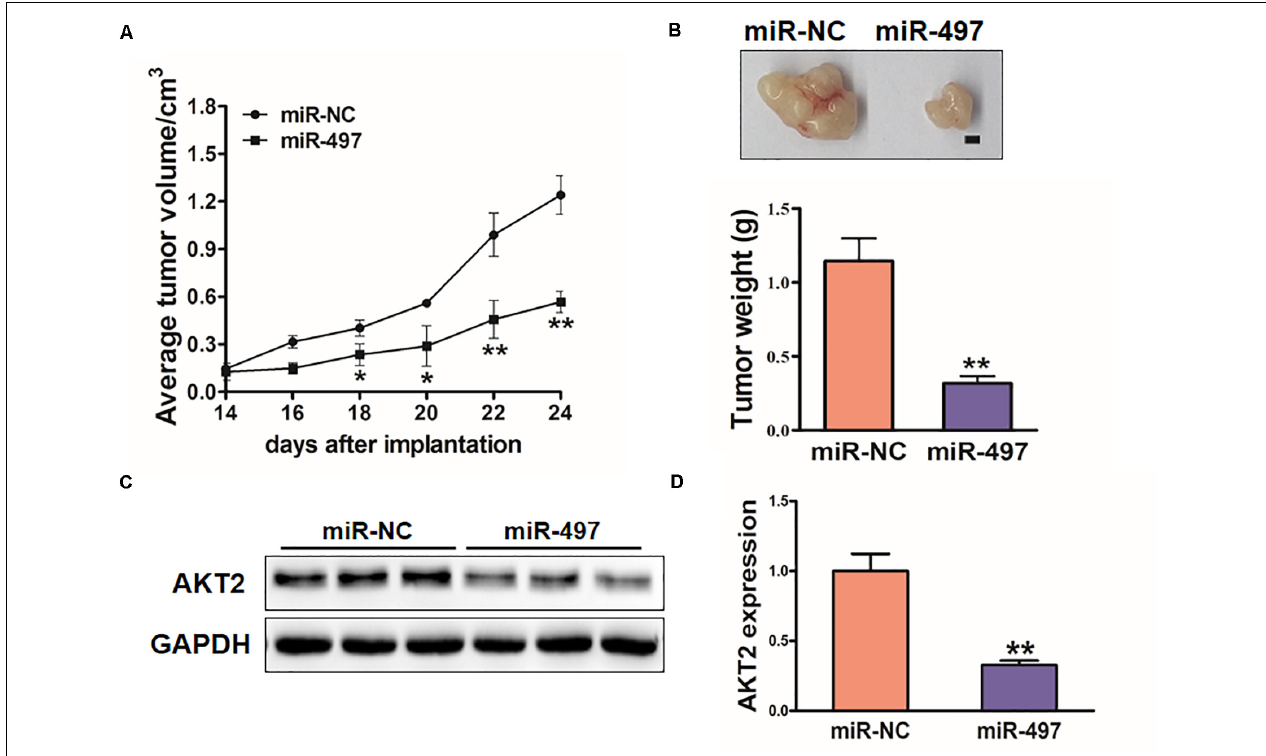
FIGURE 7 | MiR-497 inhibits tumorigenesis in vivo . (A,B) Tumor growth assay in nude mice. Tumor growth curve, representative pictures and average weight of xenograft tumors between the groups of miR-NC and miR-497. Bar: 2 mm. (C) Protein levels of AKT2 in xenograft tumors. (D) The expression levels of AKT2 were analyzed by qRT-PCR. Data were presented by mean ± SD. of 3 replicates. *indicated P < 0.05; **indicates P <